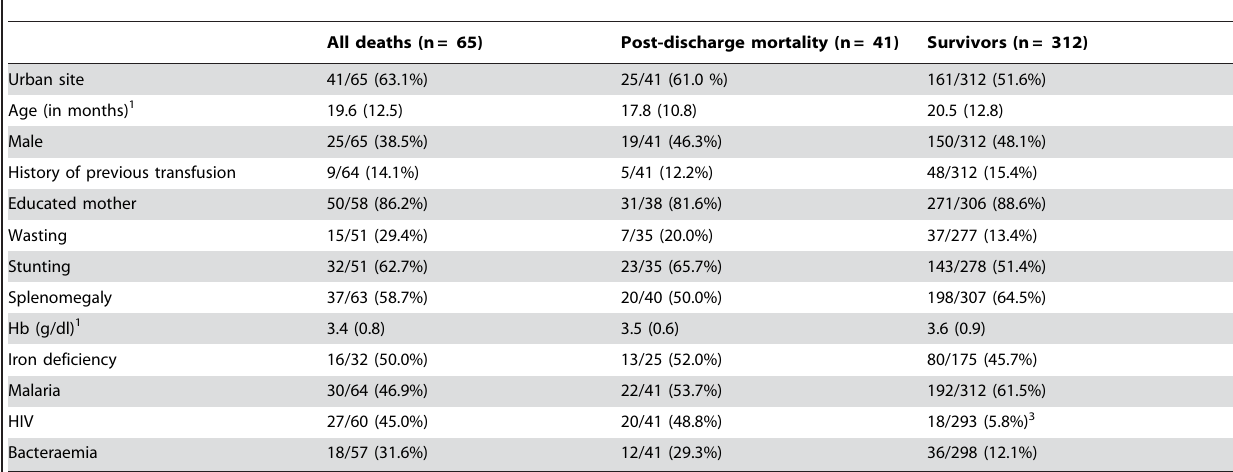
Table 3. Baseline characteristics of severe anaemia cases by